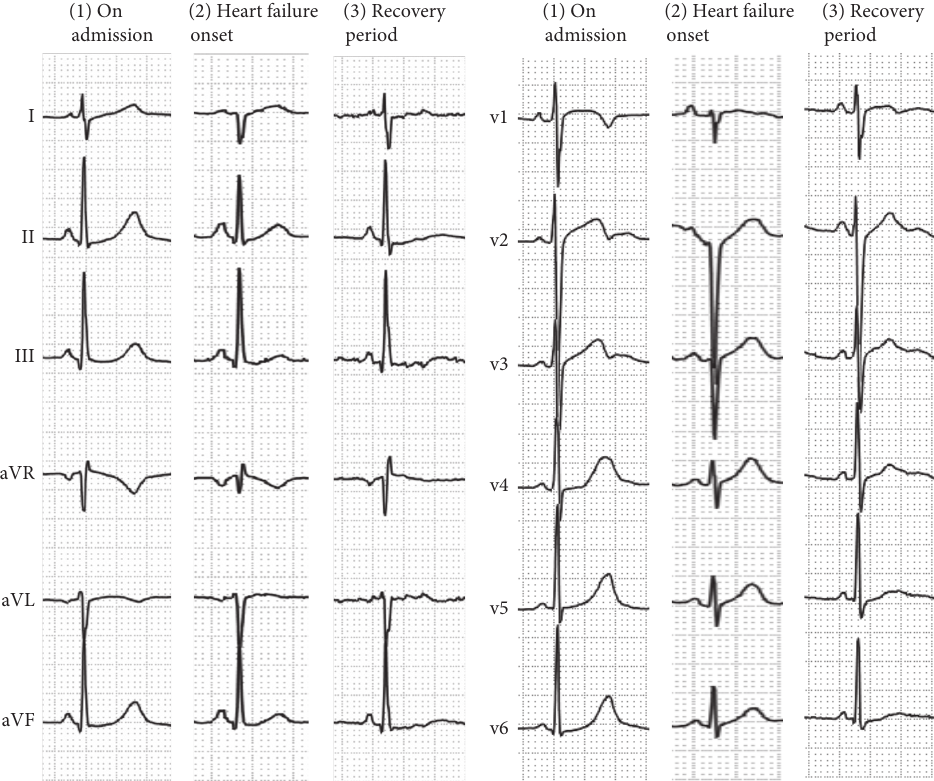
Figure 5: Time course of 12-lead electrocardiogram tracings; (1) at the time of admission; (2) at the onset of heart failure; and (3) during the recovery period (4 weeks after the onset of heart failure). A right axis shift, widespread low voltage, and left ventricular hypertrophy were observed at the onset of heart failure and subsequently